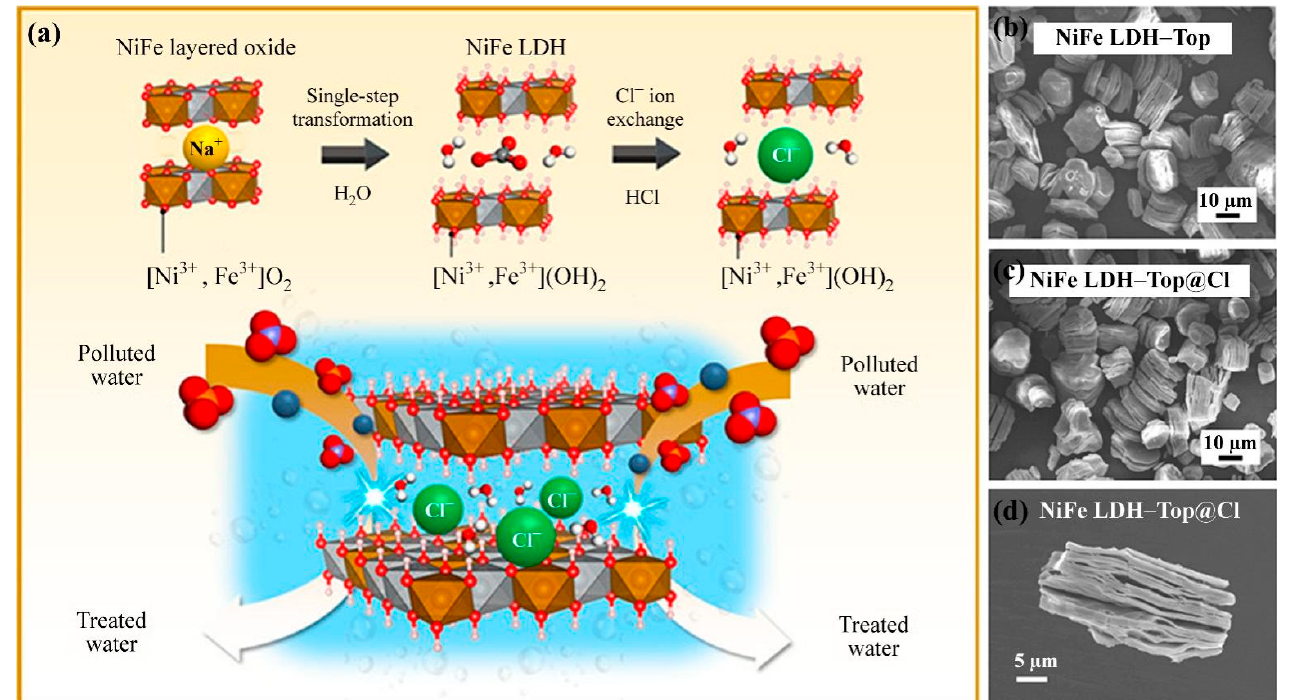
Figure 10. ( a ) Schematic of the fabrication and modification of NiFe LDH-Top@Cl. Scanning electron microscopy images of ( b ) NiFe LDH-Top (10 μ m), ( c ) NiFe LDH-Top@Cl (10 μ m), and ( d ) NiFe LDH-Top@Cl (5 μ m). Reproduced with permission from [77]. Copyright {2021} American Chemical Society.